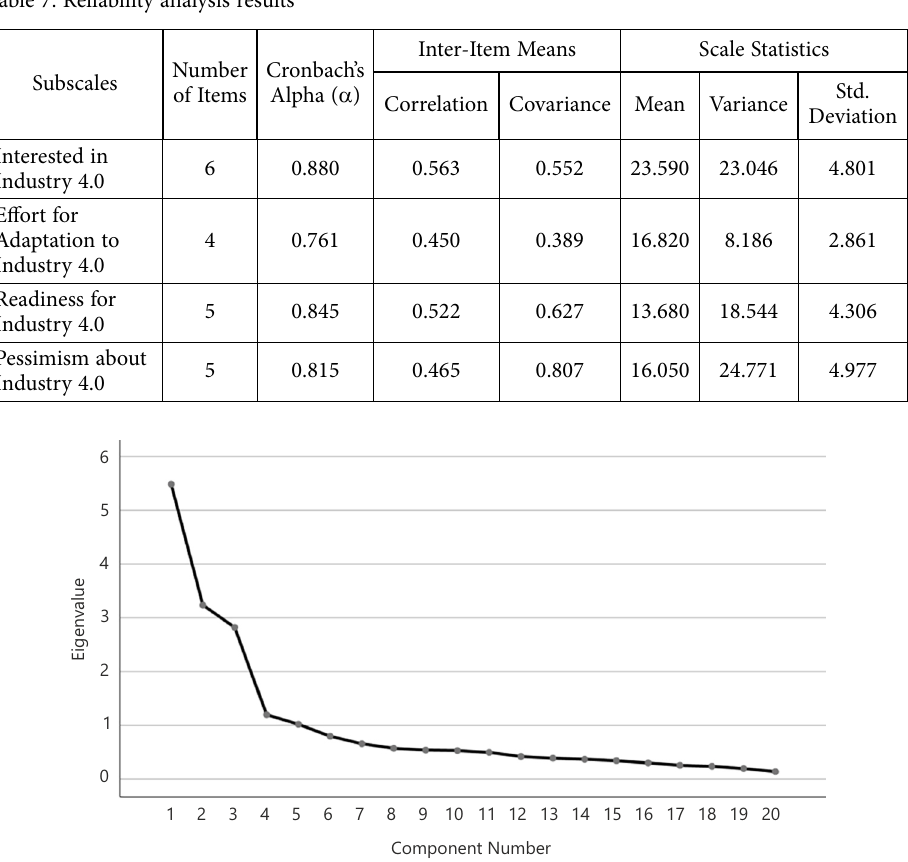
Figure 1. Scree plot for the final